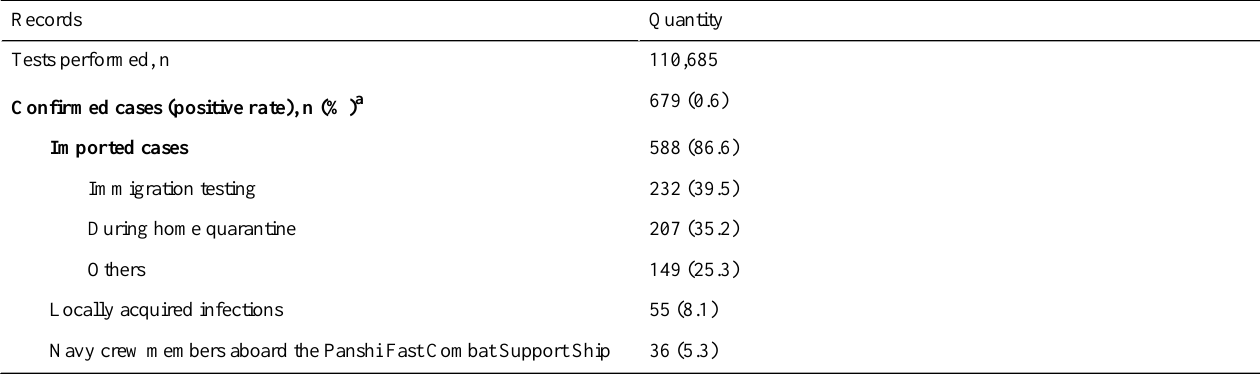
Table 1. Source of confirmed COVID-19 cases in Taiwan as on November 30,